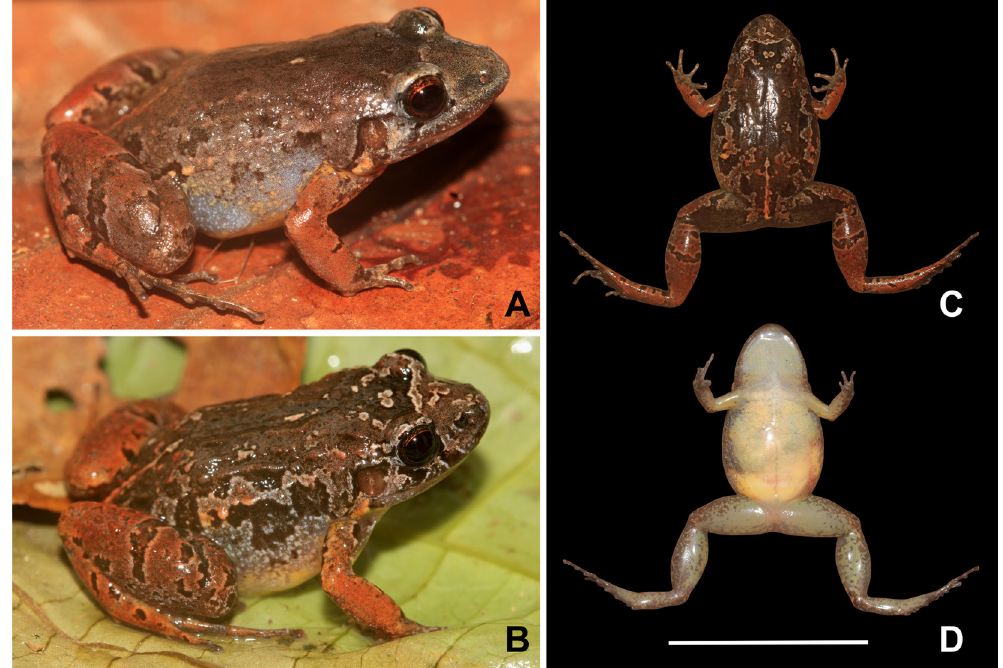
Fig. 4. Specimens of the genetic lineage 2 related to Adenomera simonstuarti (Angulo & Icochea, 2010) from the lower Juruá River, in Juruá, Brazilian state of Amazonas. A−B . Dorsolateral view of the adult male, SVL = 22.6 mm (INPA-H 39792) and the adult female, SVL = 26.1 mm (INPA-H 39814), respectively. C−D . Dorsal and ventral views of the female shown in B. Photographs by L.J.C.L. Moraes. Scale bar = 25